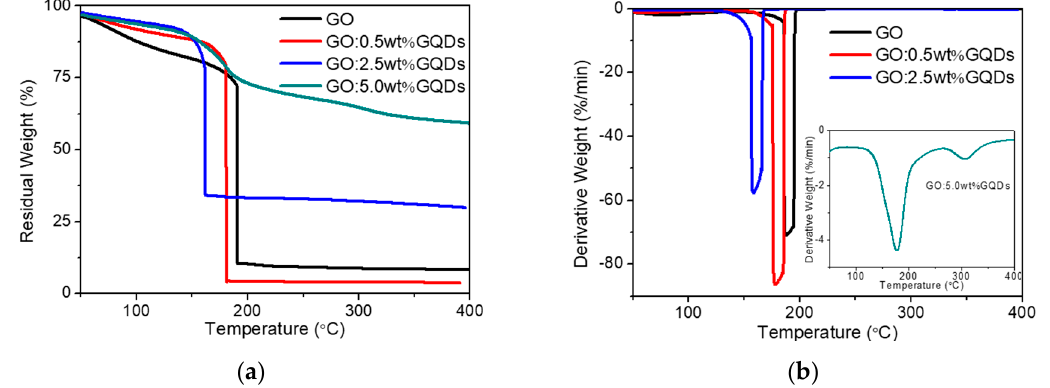
Figure 3. ( a ) Thermogravimetric analysis (TGA) and ( b ) derivative thermogravimetry (DTG) of GO as well as its nanocomposites.